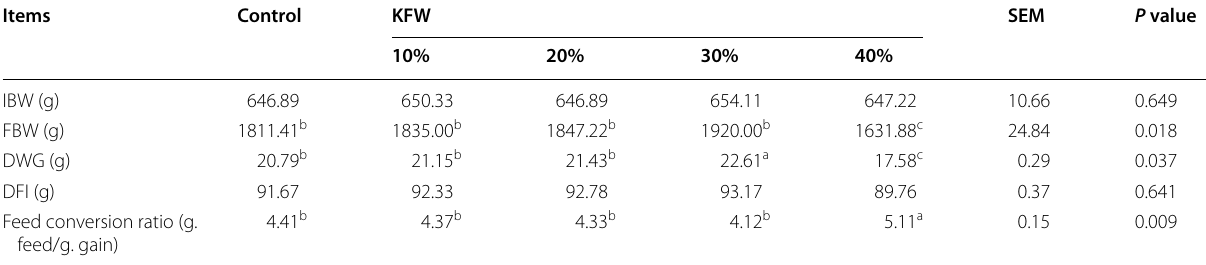
a,b,c Means with different superscripts in the same row differ significantly ( P < 0.05)